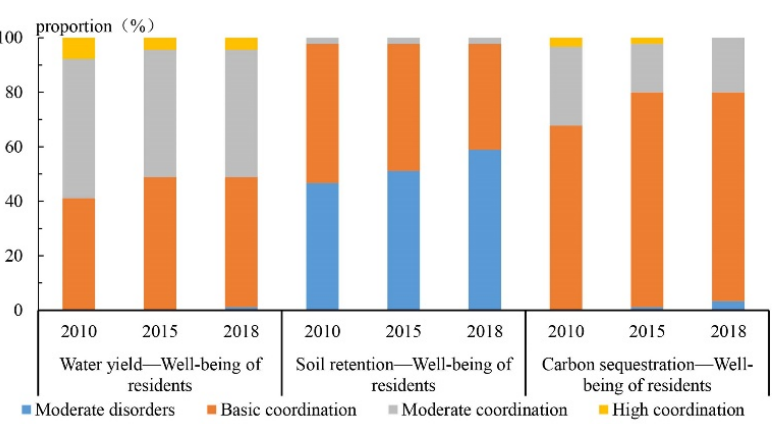
Figure 9. Changes of coupling coordination degree between ecosystem services and human well- being in Guanzhong Plain urban agglomeration from 2010 to 2018.